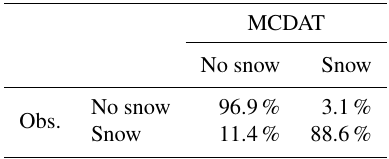
Table 1. Confusion matrix for observations of snow compared to the Modis Aqua and Terra daily snow product combined.